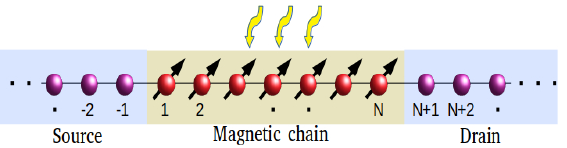
Figure 1. Spin polarized setup where a one-dimensional magnetic chain is coupled to non-magnetic source and drain electrodes. The magnetic chain is subjected to light irradiation which controls spin transfer through the